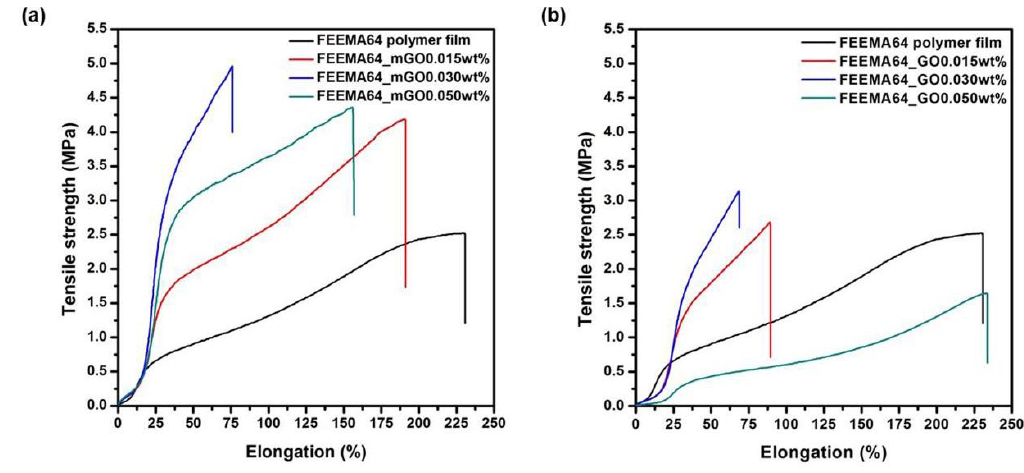
Figure 4. Mechanical properties of nanocomposites containing ( a ) mGO and ( b ) GO.